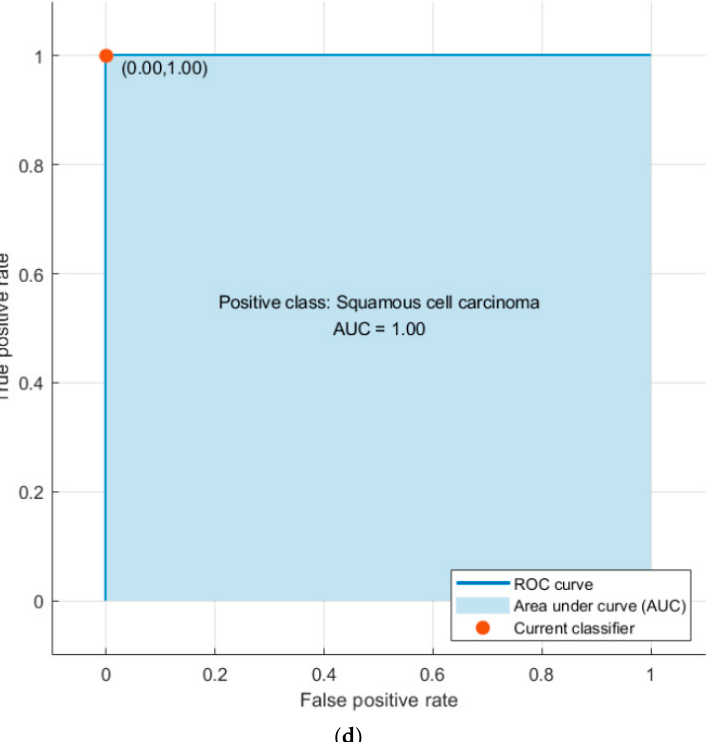
Figure 4. ROC curves of the quadratic SVM constructed with PCs generated after fusing the entire DL features with the combined handcrafted features when the positive class is: ( a ) High squamous intraepithelial, ( b ) Negative for intraepithelial ( c ) Low squamous intraepithelial, ( d ) Squamous cell carcinoma.